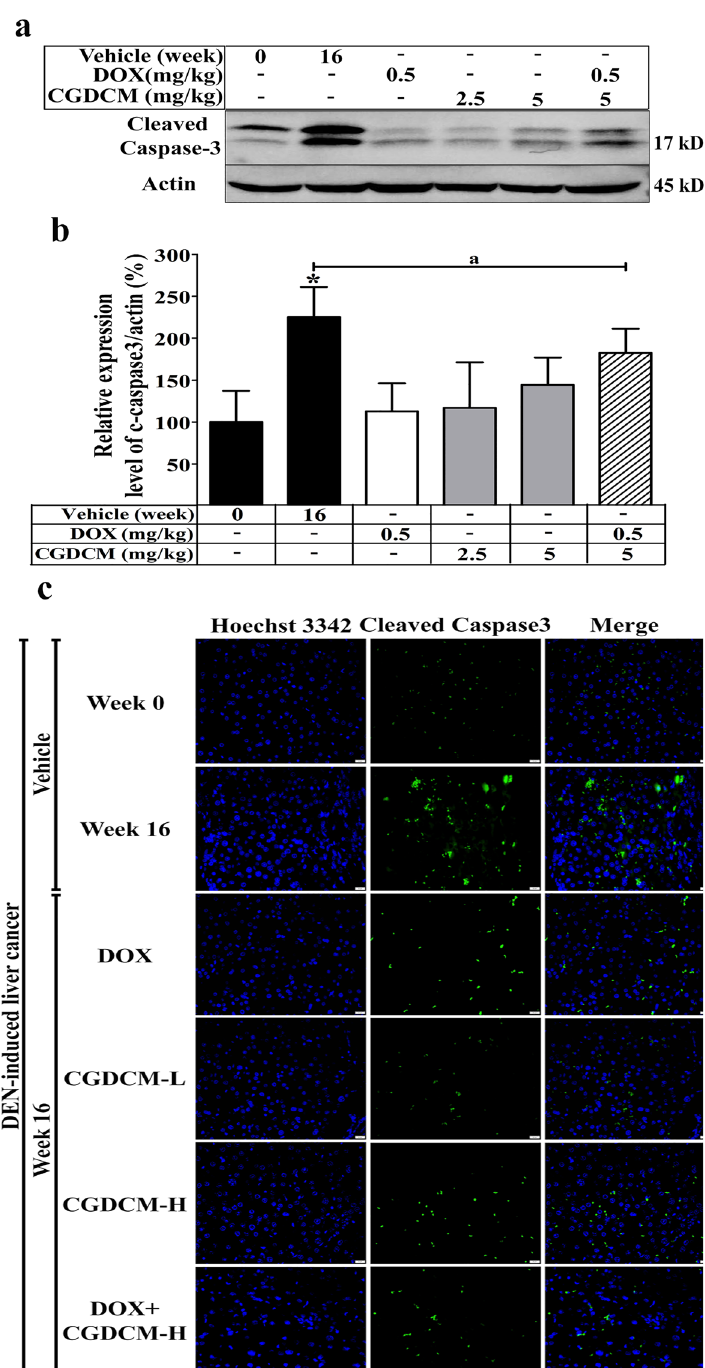
Figure 12. The effect of a combination of DOX and CGDCM extracts from stem bark of C. gigantea on the induction of apoptosis in DEN-induced liver cancer rats. DEN administration was performed for 8 weeks, and the treatments were performed for 4 weeks from week 12, which included DOX, CGDCM-L, CGDCM-H, and the combination of DOX with CGDCM-H. The vehicle group was treated with 0.8% DMSO. Representative images from the liver tissue by western blot analysis of ( a ) cleaved caspase-3 and ( b ) quantification of the expression as a percentage of β-actin/protein expression. ( c ) Representative images of cleaved caspase-3 expression visualized by fluorescence microscopy and counterstained with Hoechst 33342, bars = 20 µm. The data are reported as the mean ± SD (n = 3) and were analyzed using one-way ANOVA with Tukey’s HSD test, *p < 0.05 compared to week 0. CGDCM , C. gigantea dichloromethane extract; CGDCM-L, CGDCM low dose; CGDCM-H, CGDCM high dose; DOX ,